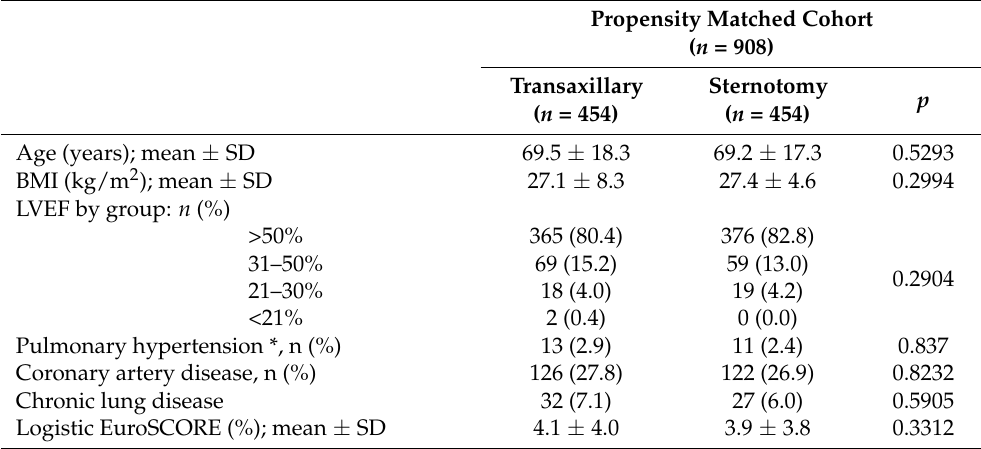
Table 1. Univariate analysis of balanced matching parameters after 1:1 propensity score matching.